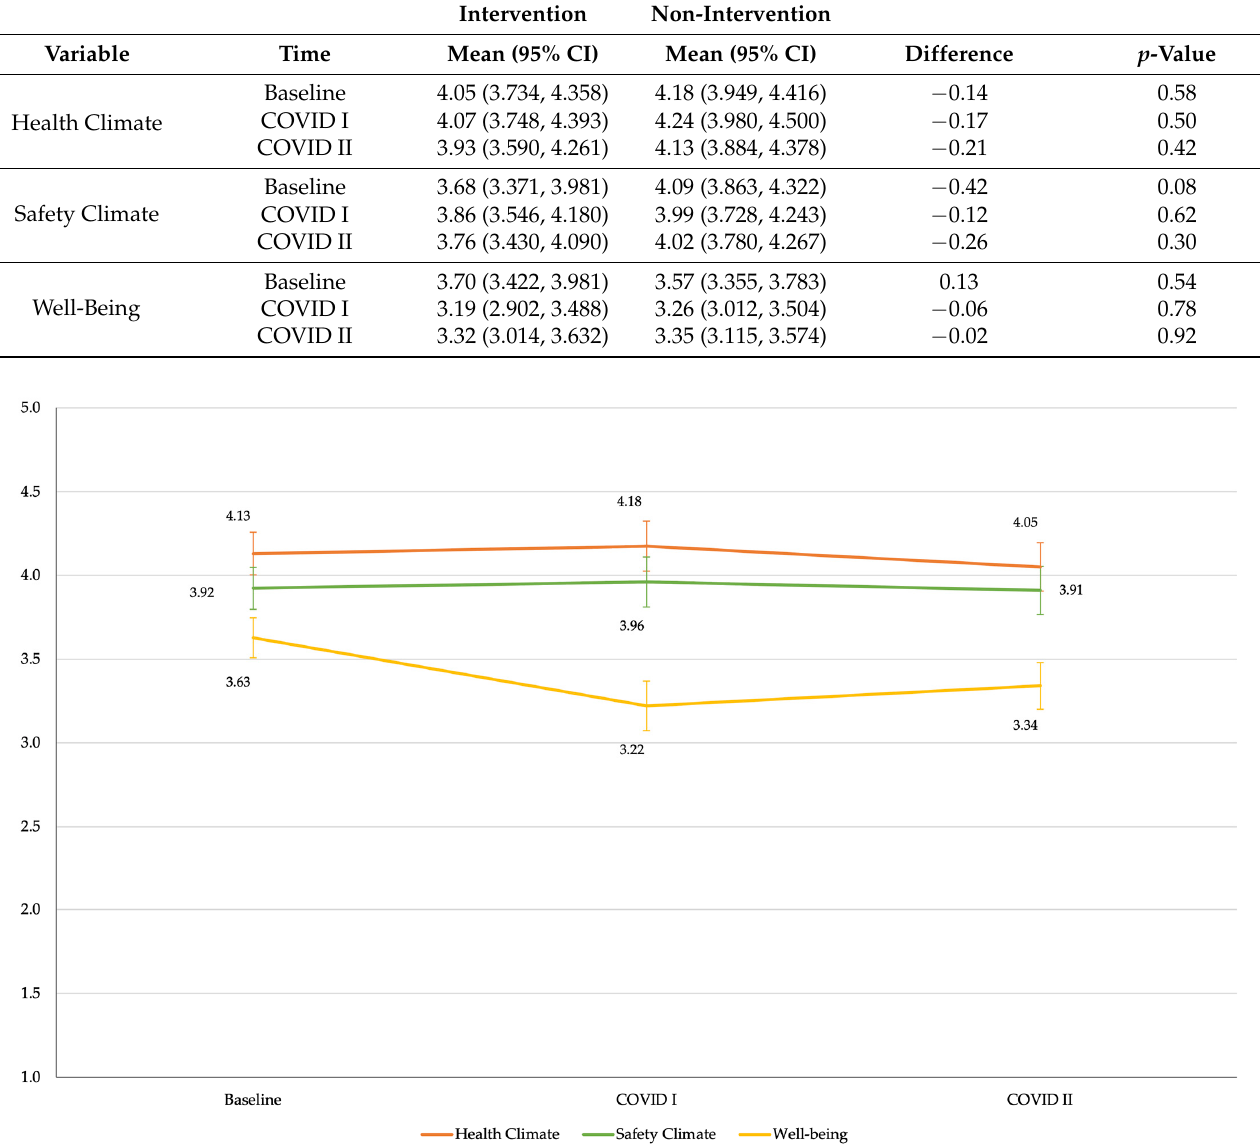
Table 2. Least squares mean estimation of health climate, safety climate, and well-being at each survey occasion stratified by intervention group.